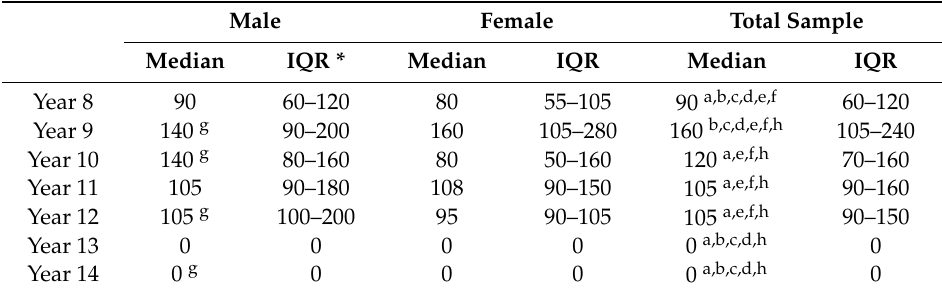
Table 5. Minutes of weekly physical education per year group (post-primary).